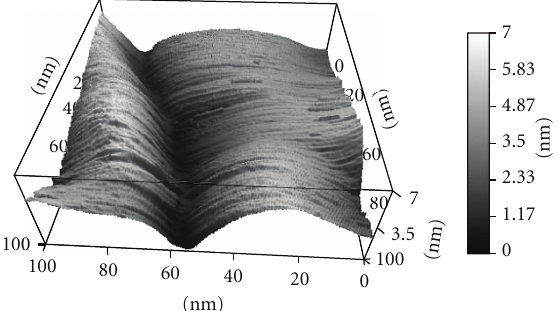
Figure 1: AFM image of grain boundary grooving of BiFeO 3 /LaNiO 3 thin